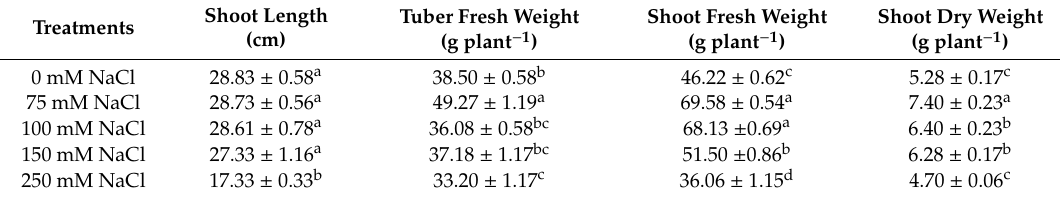
Table 1. E ff ects of soil salinity on shoot length (SL), tuber fresh weight (TFW), shoot fresh weight (SFW), and shoot dry weight (SDW) of sugar beet plant after treatments with various salt concentrations for a period of 95